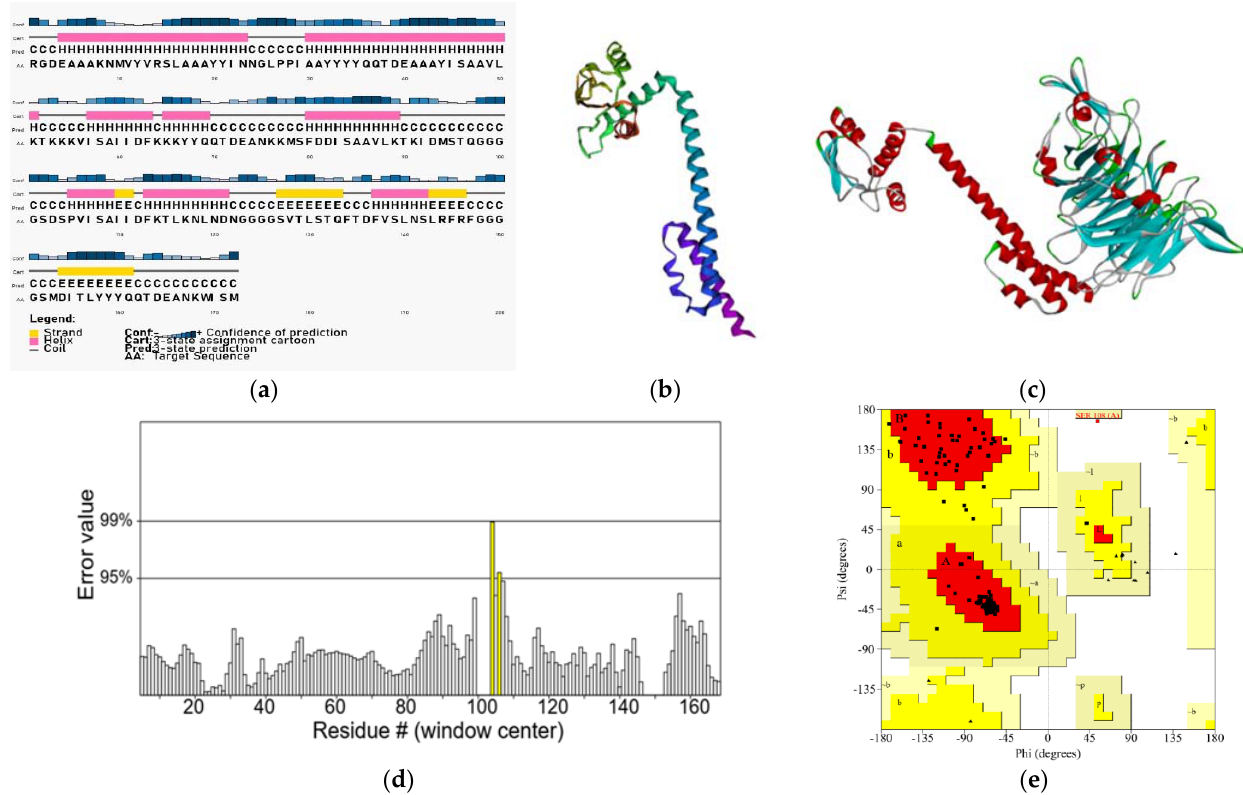
Figure 5. ( a ) The secondary structure of the vaccine. ( b ) 3D structure of the vaccine construct (from N (Purple) to C (Red) terminus) predicted by trRosetta) ( c ). Docked model of the vaccine construct (red) with an integrin receptor (cyan) visualized using BIOVIA, Dassault Systèmes, Discovery studio, 2021. ( d ) ERRAT scores of vaccine peptide. ( e ) Ramachandran plot of the vaccine peptide. A total of 93.5% residues in the favored region, 5.9% in the allowed region and only one residue in the disallowed region.